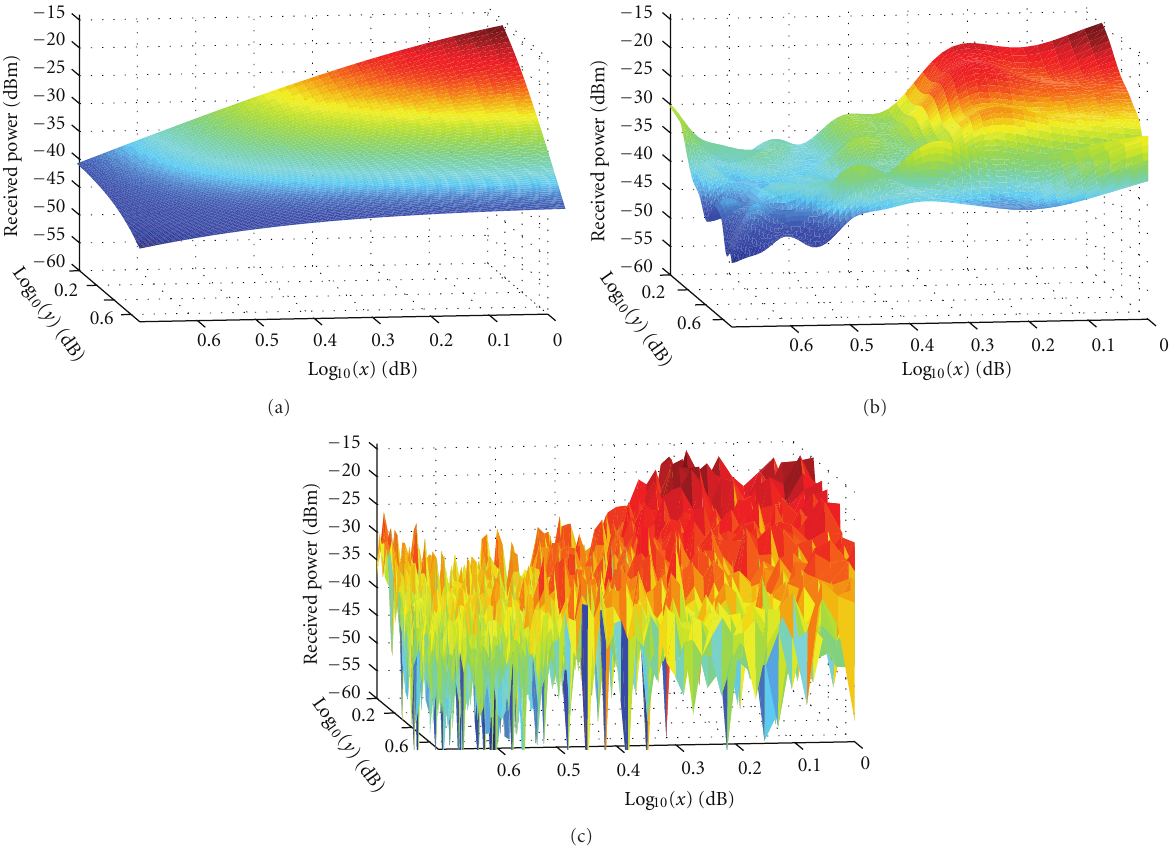
Figure 16: An example of a channel generated using the probabilistic characterization of the previous section. (a) Channel with path loss only, (b) channel with path loss and shadowing, and (c) channel with path loss, shadowing, and small-scale fading. Transmitter is in the top right